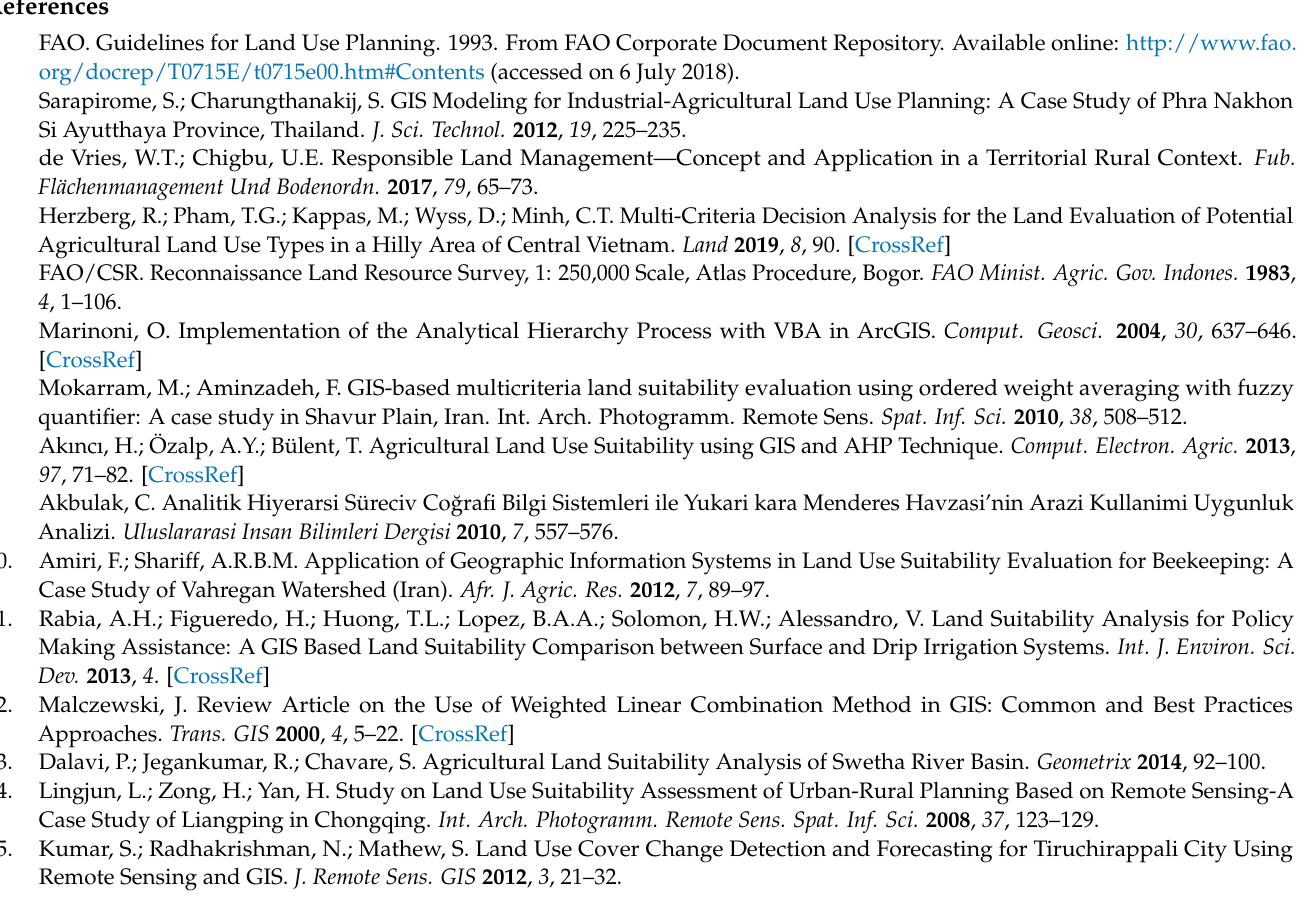
The consistency ratio per land use is achieved after filling in the comparison matrices based on the geometric mean of the individual preferences which also achieved consistency prior to the computation of the geometric